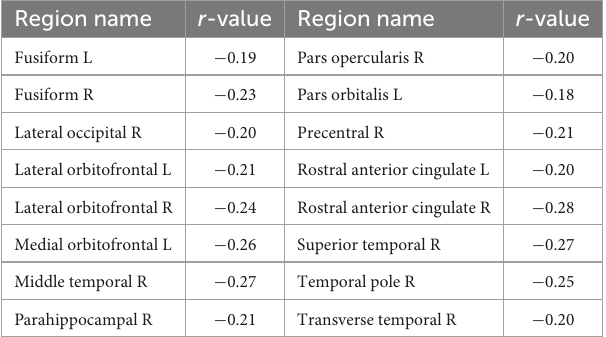
TABLE 1 Significant correlation r -values between alpha peak amplitude and depressive score.